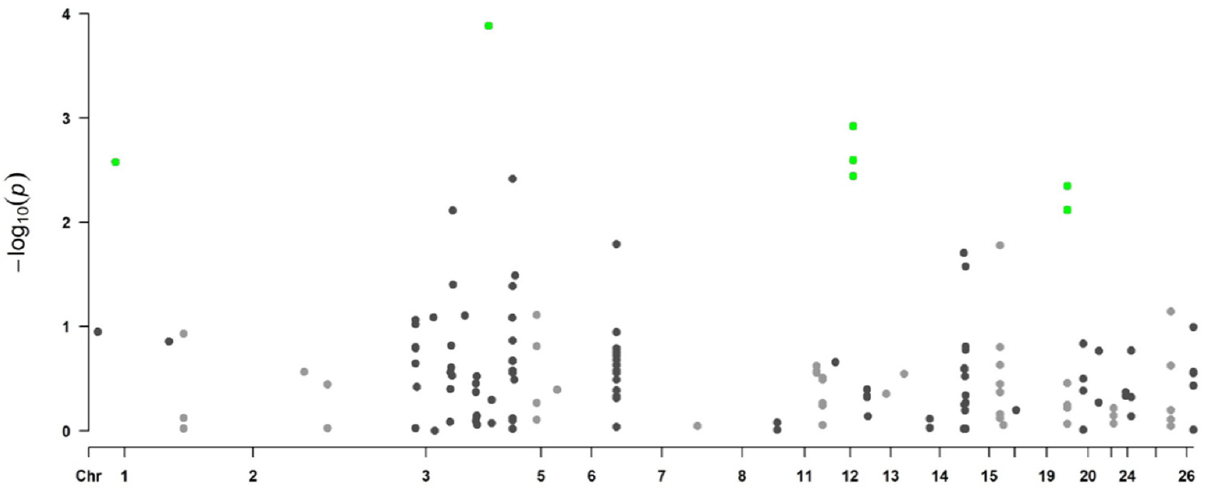
Figure 2. Manhattan plot for logFEC representing genome-wide associations using 170 SNPs and 454 genotyped individuals. Y -axis shows each SNP -log 10 ( p -value) and x -axis shows the SNP position across the 26 chromosomes. Green dots represent the significant SNPs using a chromosome-wise FDR of 5%, black and gray dots are non-significant SNPs.